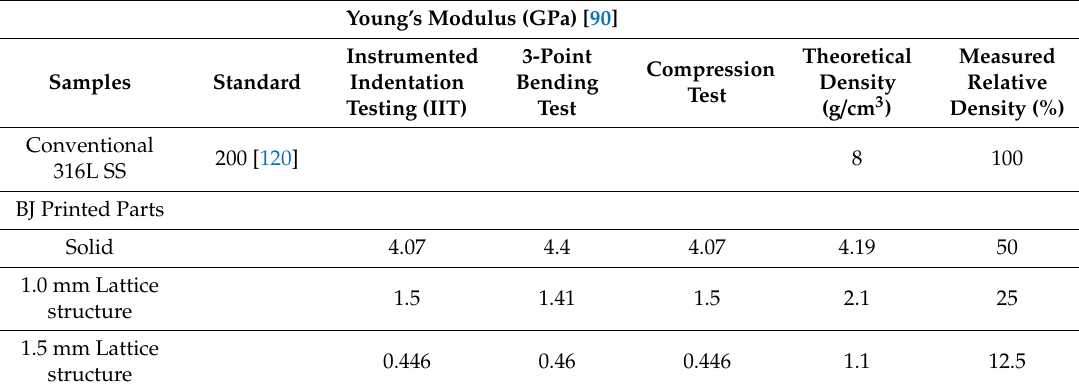
Table 15. Young’s modulus and relative density for three di ff erent samples manufactured by BJ.